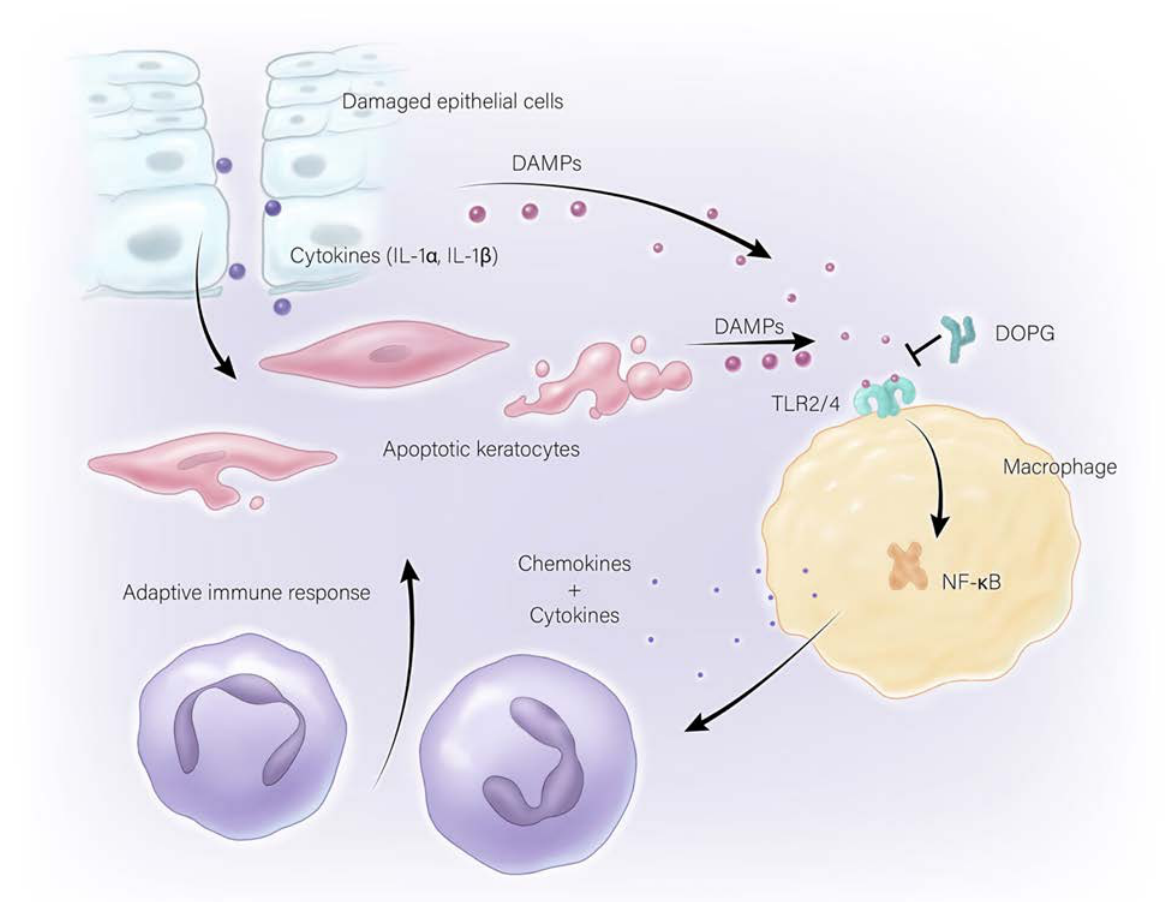
Figure 3. Innate Immune System Activation upon Corneal Wounding. As shown, corneal wounding results in the release of cytokines like interleukin-1 (IL-1), which can lead to keratocyte apoptosis and the release of endogenous molecules, called danger- or damage-associated molecular patterns (DAMPs); DAMPs can also be released from the injured corneal epithelial cells. DAMPs are able to activate pattern recognition receptors of the innate immune system such as toll-like receptors-2 and -4 (TLR2/4), which can function through the nuclear factor kappa-light-chain-enhancer of activated B cells (NFκB) pathway to induce the production and release of additional cytokines and chemo- kines that induce infiltration of innate and adaptive immune cells into the cornea. This immune cell recruitment can then lead to chronic sterile inflammation, which can in turn, impair vision. The phospholipid phosphatidylglycerol has been found to inhibit TLR2/4 activation by DAMPs and mi- crobial components known as pathogen-associated molecular patterns. This effect, as well as its ability to enhance corneal wound healing, suggest the possibility that it might be useful as a therapy to reduce inflammation and improve corneal wound healing. 7. Conclusions Inflammation is produced by the immune system in response to injury in order to prevent or combat potential microbial invasion and clear microorganisms from the wound, as discussed in Section 3.1. However, experimental evidence suggests that this initial re- sponse may be sufficient to somewhat impair wound healing, since during the course of evolution, infection was likely a greater threat to organismal survival than was a slight delay in wound closure. Thus, inhibition of wounding-induced innate immune system activation and initial inflammation, through the various manipulations discussed in pre- vious sections, improves corneal wound healing. Phosphatidylglycerol, in particular DOPG, also accelerates epithelial corneal wound healing [1], although the mechanism of its action is unknown. Phosphatidylglycerol also exerts anti-inflammatory effects as de- scribed in Section 6, suggesting that the ability of this phospholipid to inhibit PAMP- and